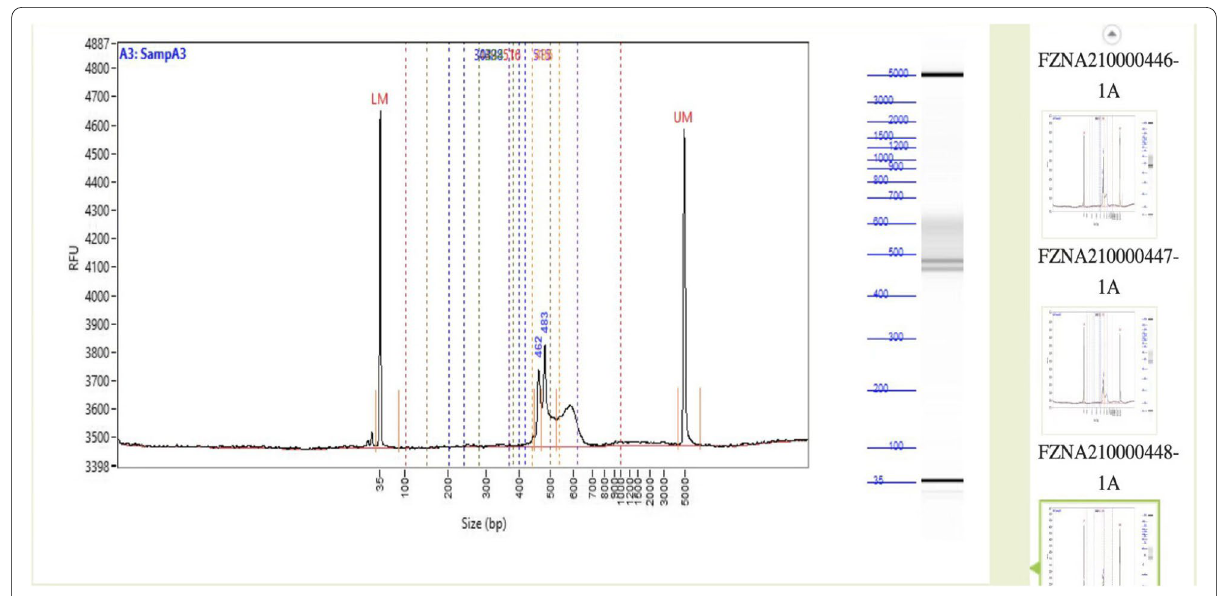
Fig. 1 Amplification product result